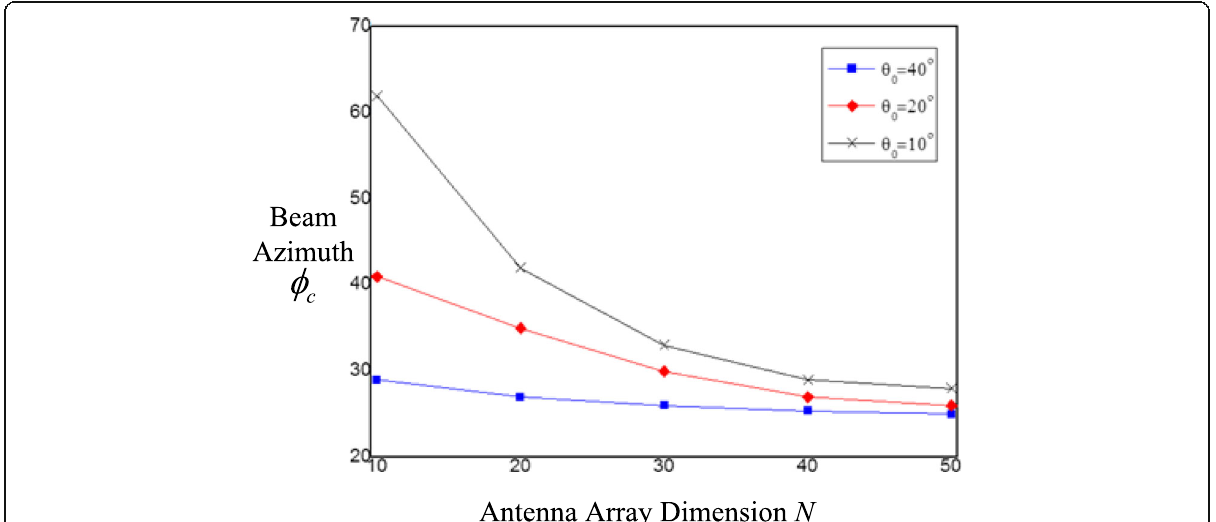
Fig. 4 The relationship of different antenna depression angles θ 0 and the beam azimuth ϕ